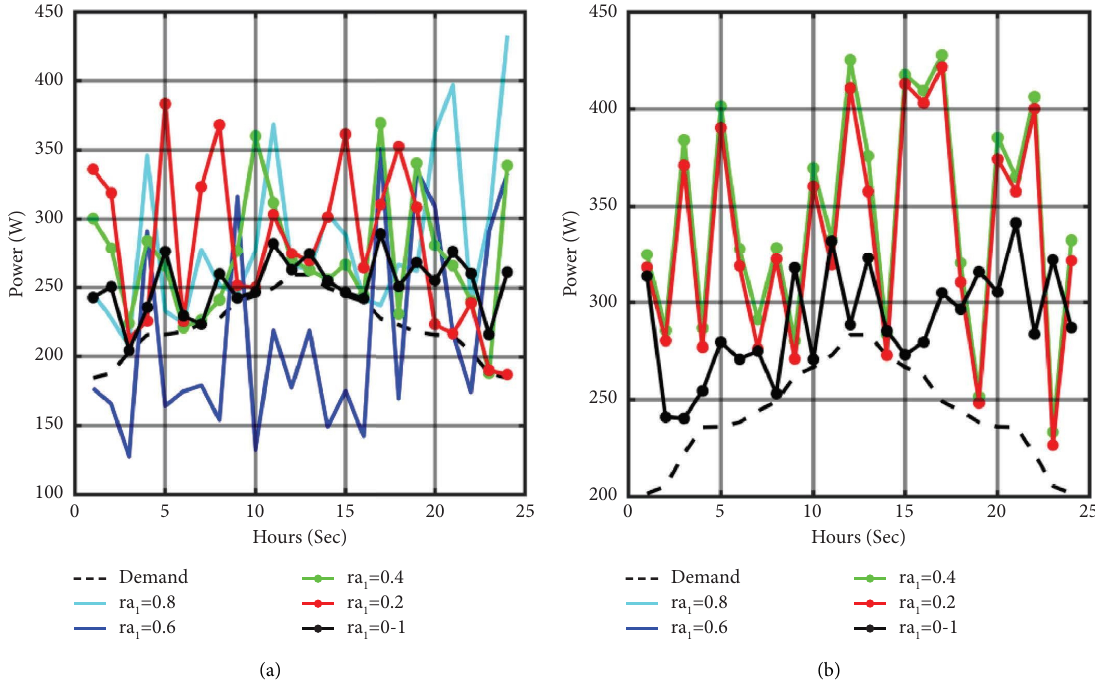
Figure 13: Demand response of the proposed POCSO algorithm at various arbitrary values for (a) IEEE-14 and (b) IEEE-30 bus